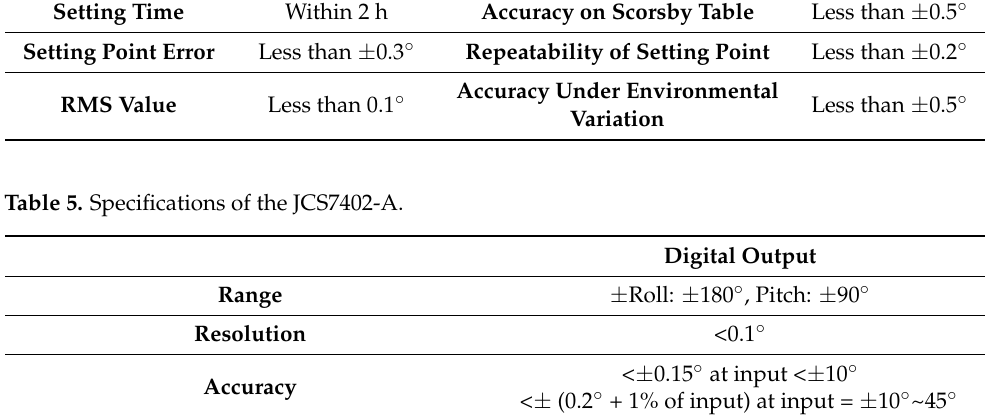
Figure 13. INS/DVL and gyrocompass heading and difference. 4.3.2. Evaluation of Speed Estimation The DVL and INS/DVL speed are compared in the B-frame. The estimated value is the value calculated from the attitude from the FOG and gyrocompass and the velocity determined by GPS using a trajectory generator [21]. The difference between the INS/DVL and estimated values for the B-frame X-axis and Y-axis are shown in Figure 14a,b, respec- tively. The mean difference in the X-axis velocity of INS/DVL and sonar velocity against the estimated value were − 1.58 × 10 − 4 (STD of 9.322 × 10 − 2 ) and − 1.53 × 10 − 4 (STD of 9.631 × 10 − 2 ), respectively. The average difference between the Y-axis INS/DVL and sonar veloci- ties and the estimated values were 1.15 × 10 − 1 (STD of 1.580 × 10 − 1 ) and 1.21 × 10 − 1 (STD of 2.168 × 10 − 1 ), respectively, which were larger than that of the X-axis. As can be seen from the average, a bias-like component was detected for the Y-axis. For improving the accu- racy, it might be necessary to use a better accelerometer to improve the accuracy of speed estimation of the INS, because it is difficult to replace the Doppler sonar.